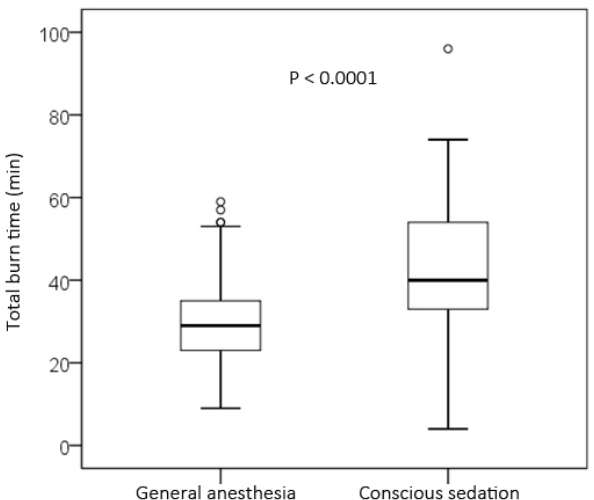
Fig. 3. Total burn time.